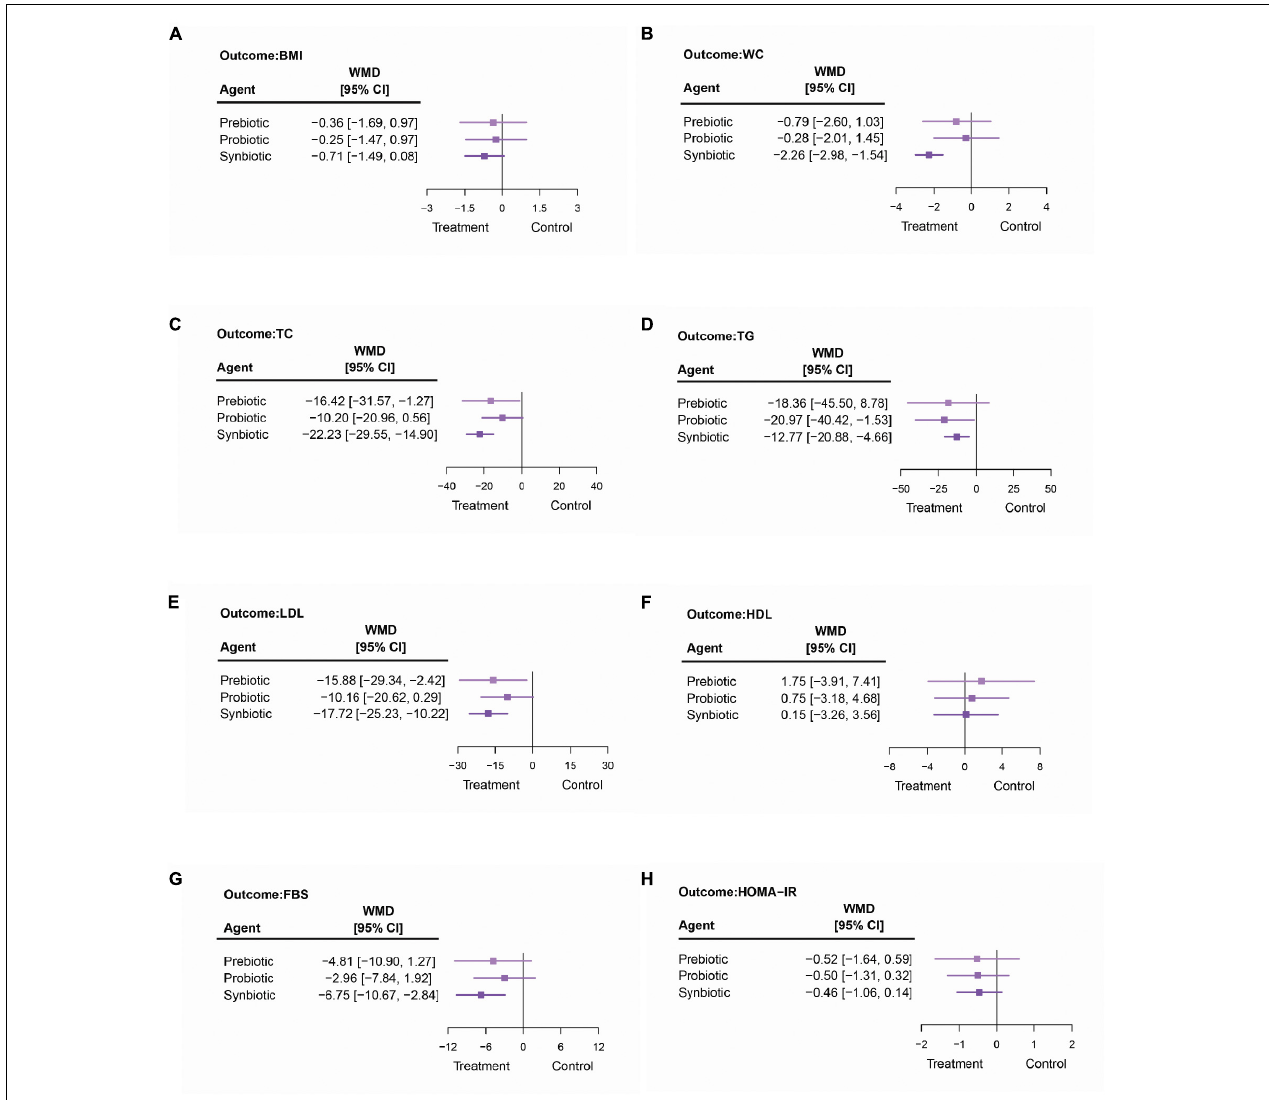
FIGURE 4 | The summarized results of using synbiotics, probiotics, and prebiotics for the modifications in (A) body mass index (BMI), (B) waist circumference (WC), (C) total cholesterol (TC), (D) triglycerides (TG), (E) low-density lipoproteins (LDL), (F) high-density lipoproteins (HDL), (G) fasting blood sugar (FBS), and (H) homeostatic model assessment-insulin resistance